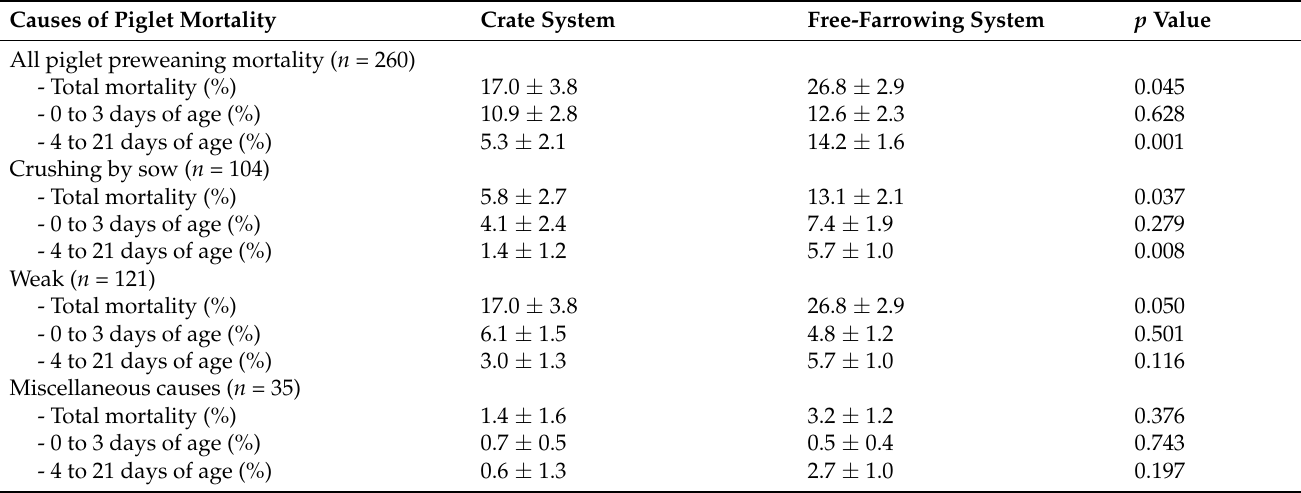
Table 4. Causes of piglet mortality during the lactation period in the crate system and the free- farrowing